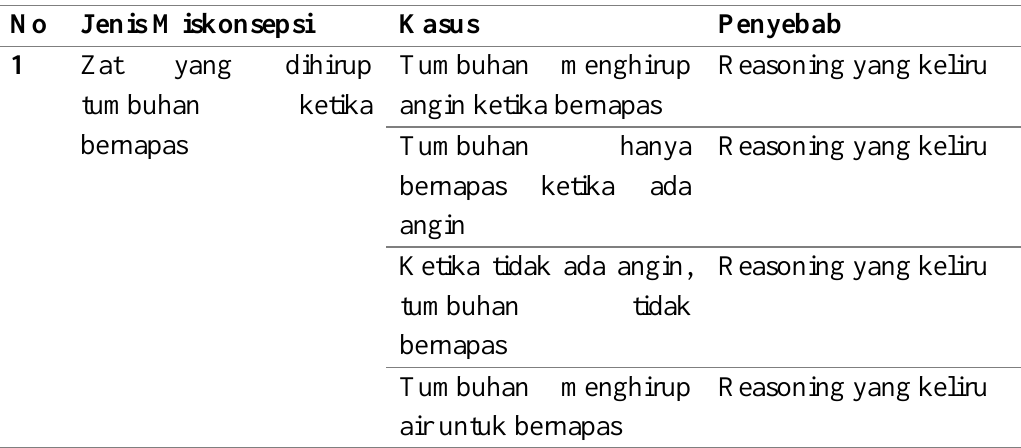
Tabel 3. Miskonsepsi Siswa SD pada Materi